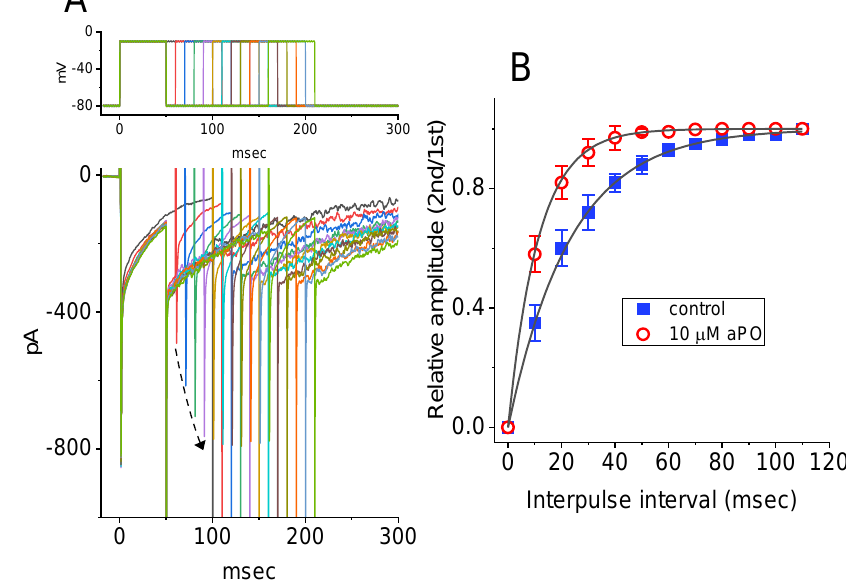
Figure 3. Effect of aPO on the time course of recovery from I Na inactivation. The cell tested was depolarized from − 80 to − 10 mV with a duration of 50 ms, and voltage-clamp commands with varying durations of interpulse interval (i.e., the interval between the first and second pulses) were applied to it. ( A ) Superimposed I Na traces in the presence of 10 µ M aPO . The upper part shows the voltage protocol applied. The dashed arrow indicates the trajectory of current inactivation elicited by different durations of interpulse pulse. ( B ) Effect of aPO on the time course of recovery from current inactivation, as the cells examined were depolarized from −80 to −10 mV. ■ : control; ○ : aPO (10 μM). Each smooth line was optimally fitted by a single-exponential function. The relative amplitude denotes that the peak I Na taken at the second pulse is divided by that at the first one. Each point represents the mean ± SEM (n = 8). The statistical analyses were undertaken by ANOVA-2 for repeated measures, p ( factor 1, groups among data ken at different interpulse intervals) < 0.05, p (factor 2, groups between the absence and presence of aPO ) < 0.05, p (interaction) < 0.05, followed by post-hoc Fisher’s least-significant difference test, p < 0.05).